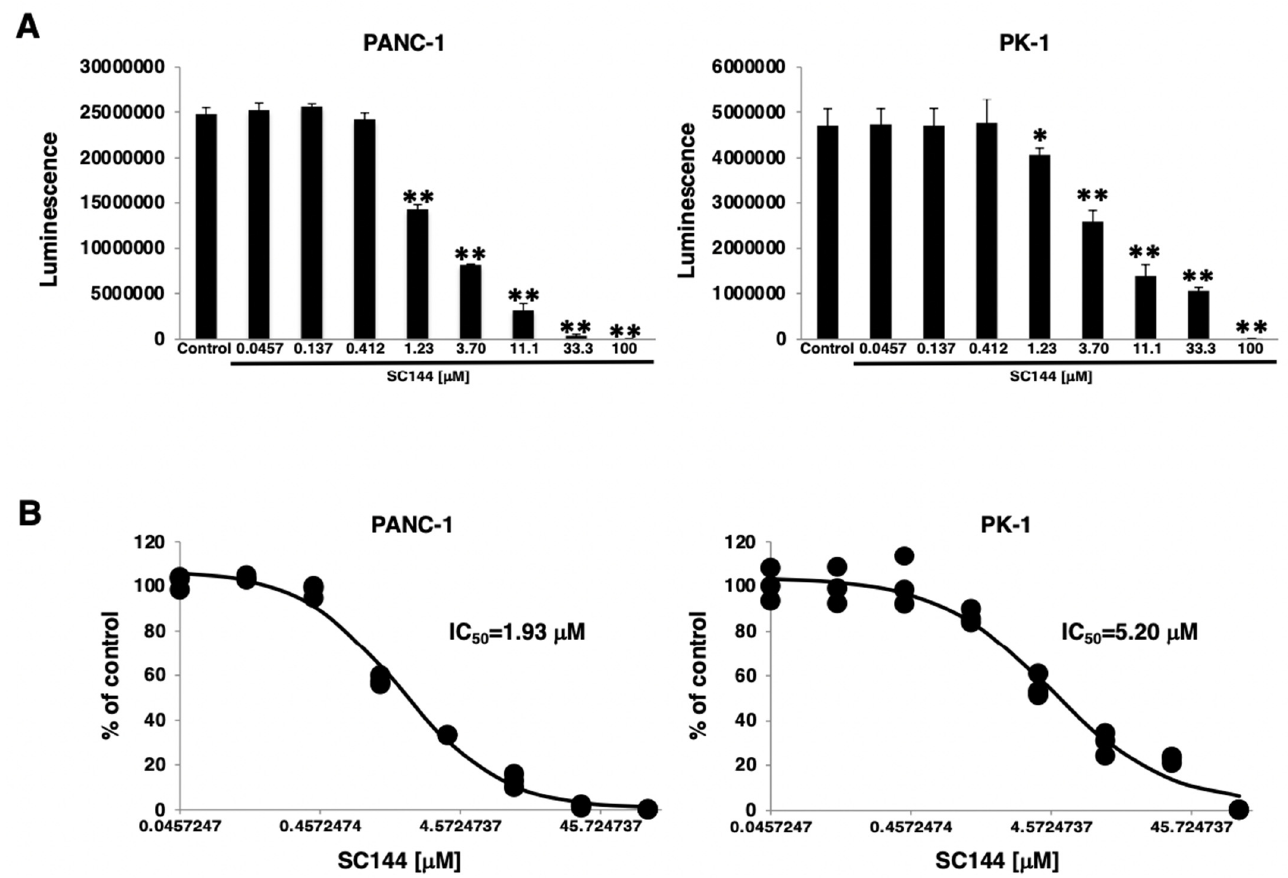
Figure 2. Dose-dependent growth inhibition via gp130 inhibitor treatment in PDAC sphere cells.